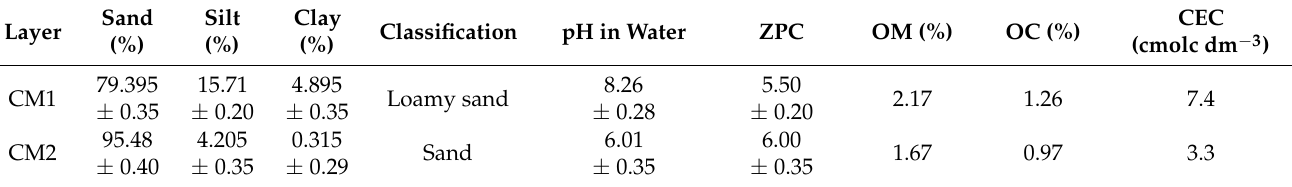
Table 1. Main characteristics of the analyzed soils (from